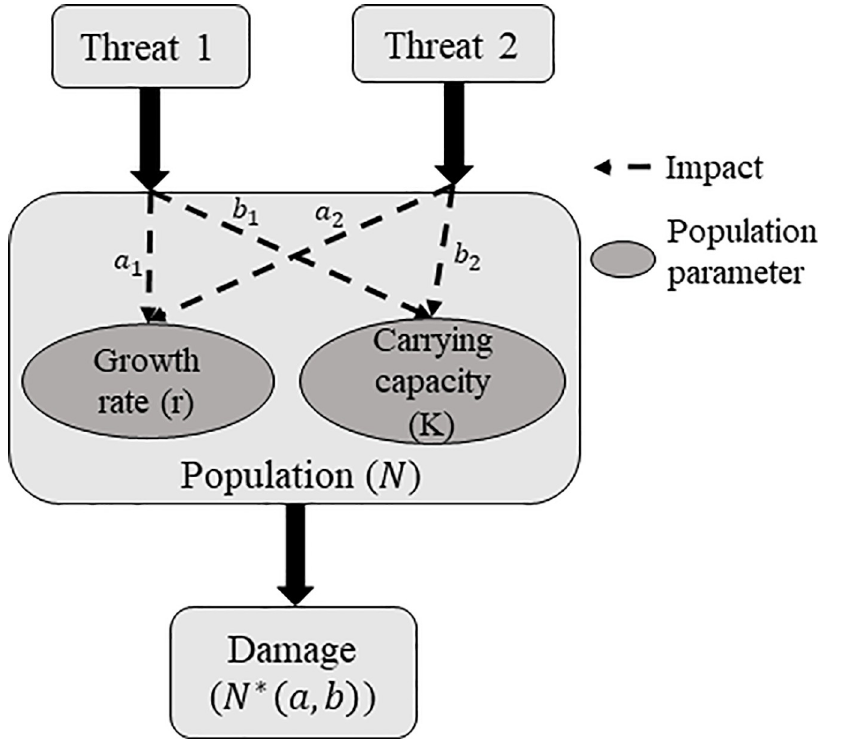
Fig 1. Schematic diagram of the stages through which threats impact